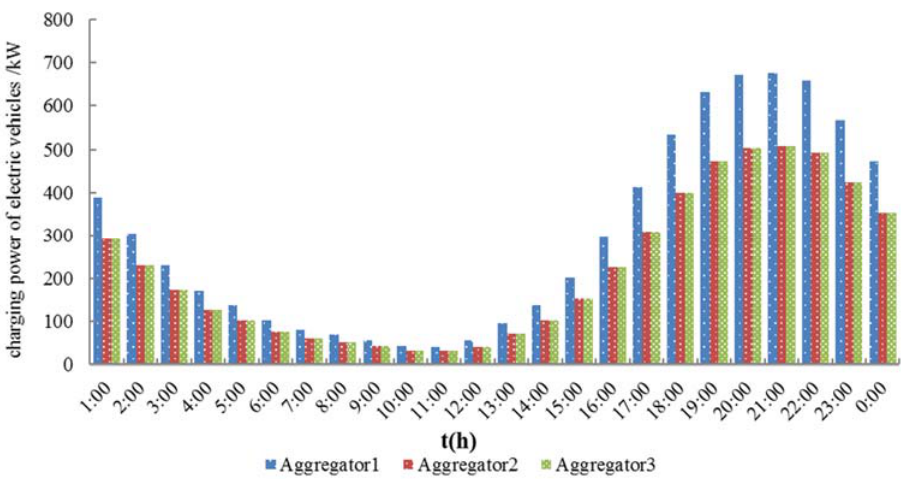
Figure 3. Charging power distribution of each aggregator in EV free charging mode.